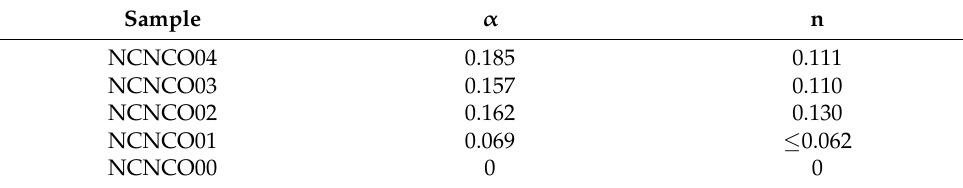
Table 5. Ni(III) share, α , in the NCNCO samples evaluated from the XPS data. Sample